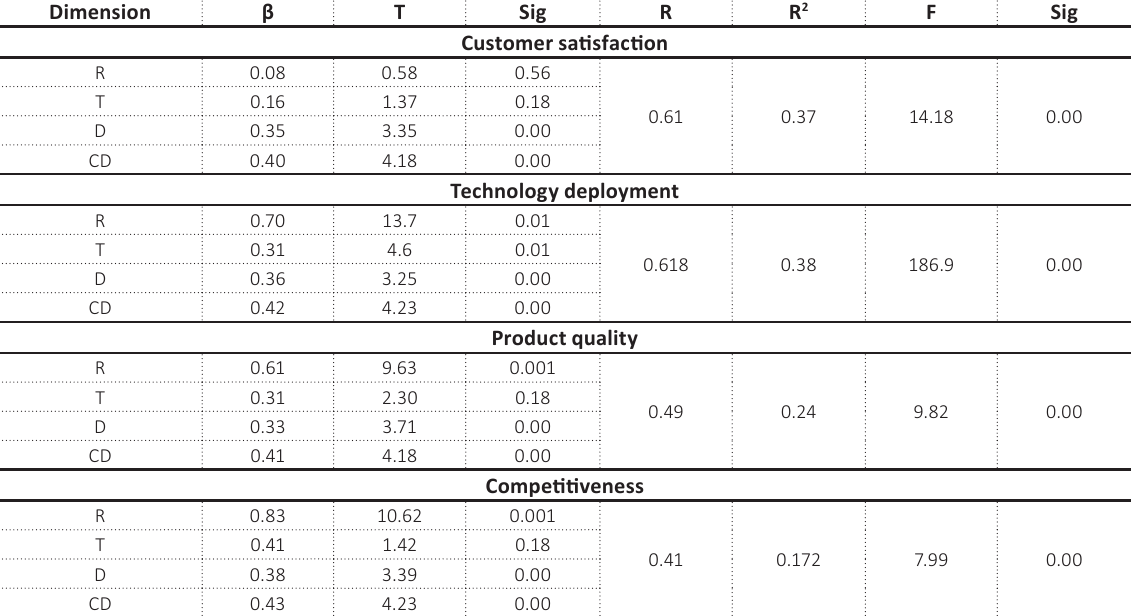
Table 10. Multivariate analysis for the effect of SHRM components on organizational excellence